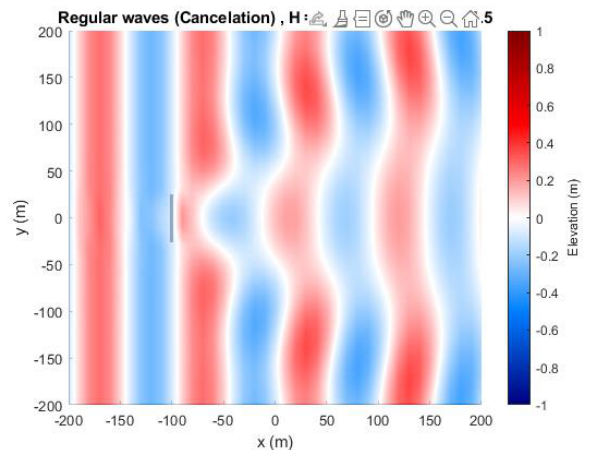
Figure 7: The resulting free surface elevation under regular wave condition with 𝑠 𝜆⁄ = 0.5